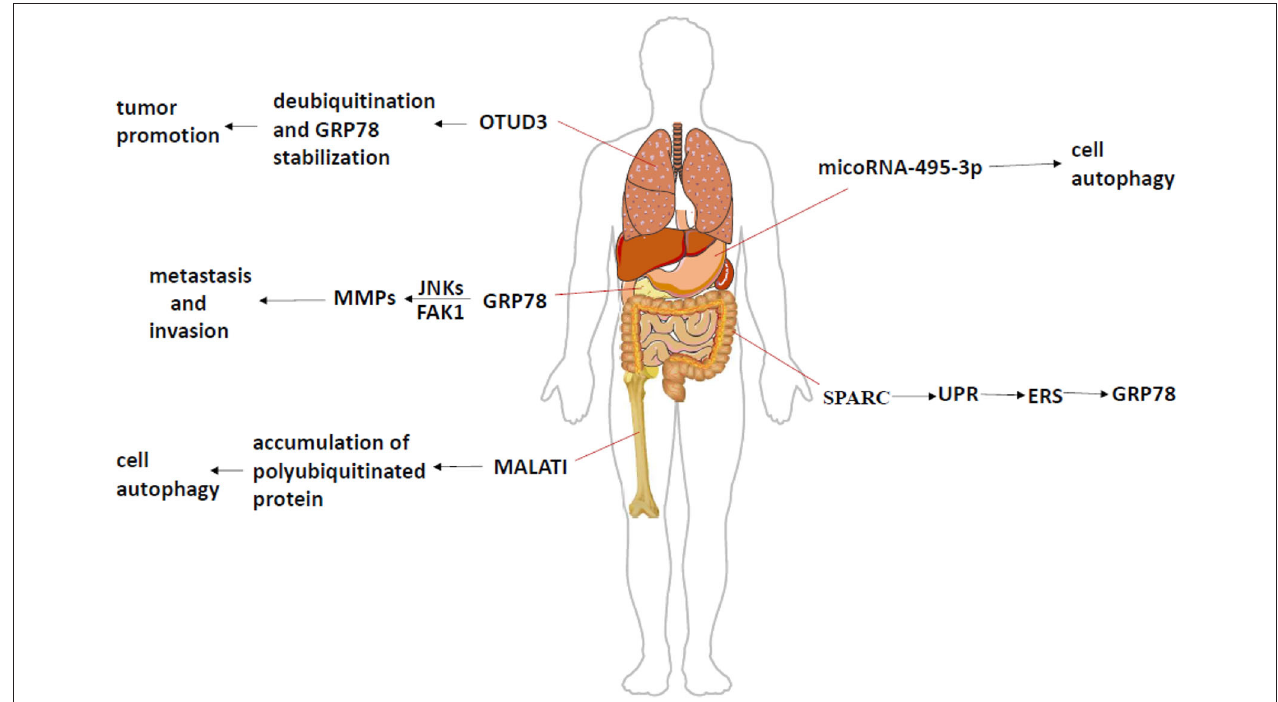
FIGURE 1 | The mechanism of GRP78 in different tumors. In lung adenocarcinoma, GRP78, as a specific substrate of OTUD3, mediates deubiquitination under the state of high expression of OTUD3, and enables the stable proliferation of tumor cells. GRP78 activates JNKs and FAK1 pathways in pancreatic cancer, and then increases the expression of downstream products and promotes tumor invasion and metastasis. In the process of multiple myeloma, the expression of MALATI will lead to the accumulation of polyubiquitinated proteins, which will activate ERS, promote the expression of GRP78, and induce cell apoptosis. MicroRNA in gastric cancer leads to different malignant phenotypes through different effects on GRP78. SPARC can interfere ERS by affecting UPR in patients with colorectal cancer, thereby changing the expression of GRP78 and controlling the apoptosis of different